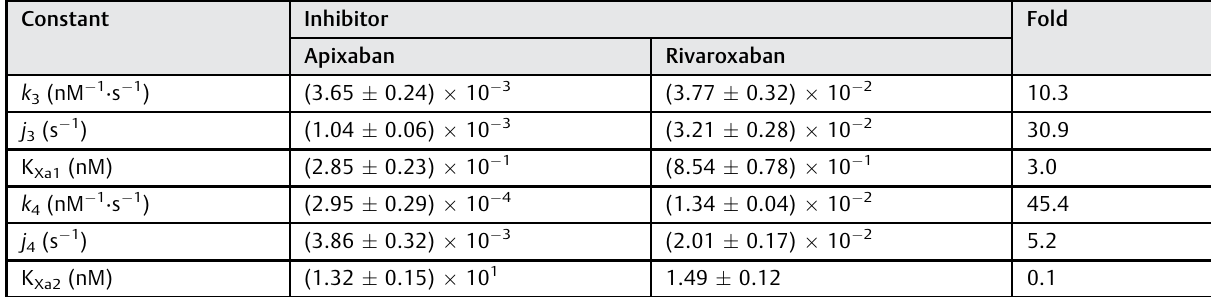
Table 1 Kinetic parameters of factor Xa inhibition by apixaban and rivaroxaban determined according to ► Scheme 1 by nonlinear regression analyses of chromogenic substrate cleavage data Constant Inhibitor Fold